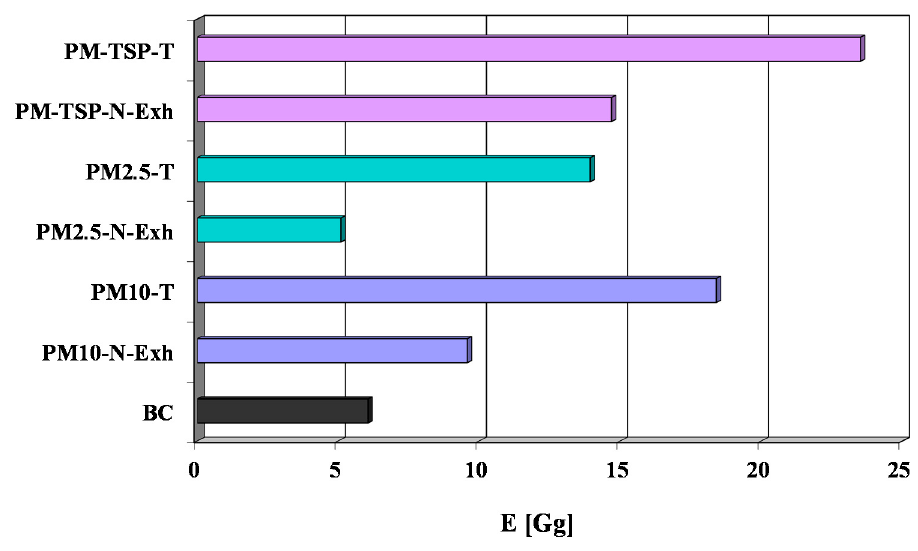
Figure 6. National annual emissions (E) of particulate matter from road transport.